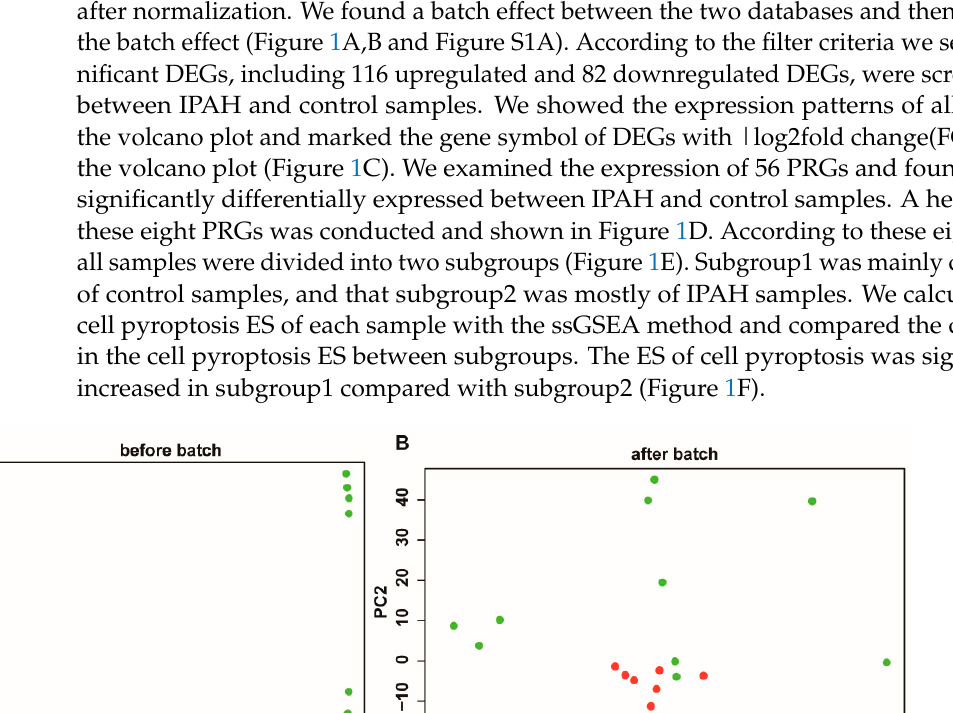
Figure 1. Data processing and sample clustering. ( A , B ) Principal Components Analysis of all sam- ples before and after removing batch effect. ( C ) Volcano plot of all the gene expression altered in IPAH compared to the control samples. ( D ) The Heatmap plot showed the expression of 8 PRGs in each sample. ( E ) Sample clustering was performed based on the expression of 8 PRGs between IPAH and control samples. Color intensity was proportional to IPAH status, the ES of pyroptosis, sub- group, sample age, and gender. ( F ) The ES of pyroptosis between subgroups. 2.2. Construct the Co-Expression Network and Identify IPAH Related Modules We selected all genes to construct the co-expression network to reduce the adverse effect of artificially setting screening criteria on the DEGs. All samples were performed a cluster analysis to detect outliers, and we found no outliers. The soft threshold power of β was five (scale independence = 0.9) based on the scale-free topology criterion (Figure 2A). We checked the scale-free topology when soft threshold power β = 5 and found that the selected β value could establish a scale-free network of genes (scale-free R2 =0.85, Fig- ure S1B). According to our screening criteria, we identified 24 modules in the network